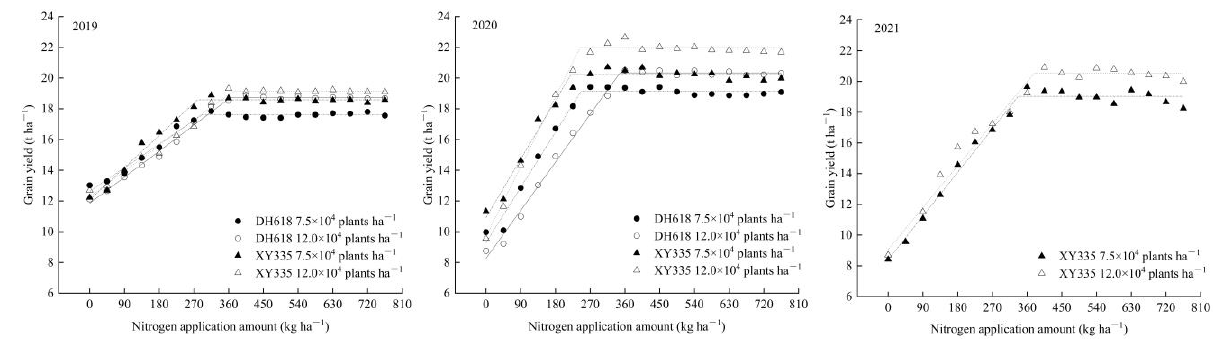
Figure 1. Effect of different nitrogen application rates on maize yield. Table 3. Fitting equation of the relationship between nitrogen application and maize yield.